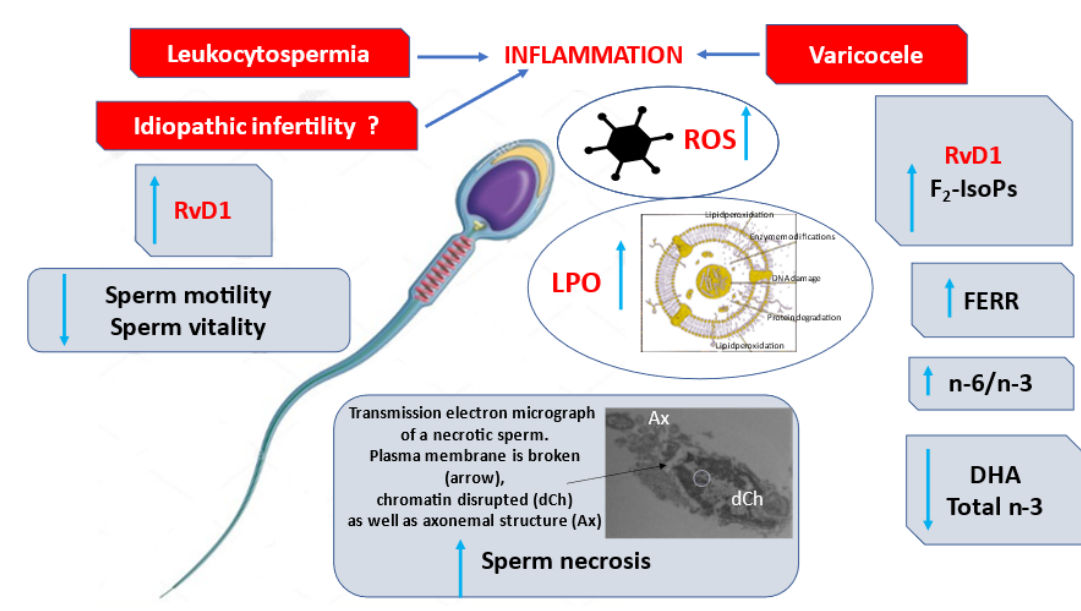
Figure 5. The data from the study .